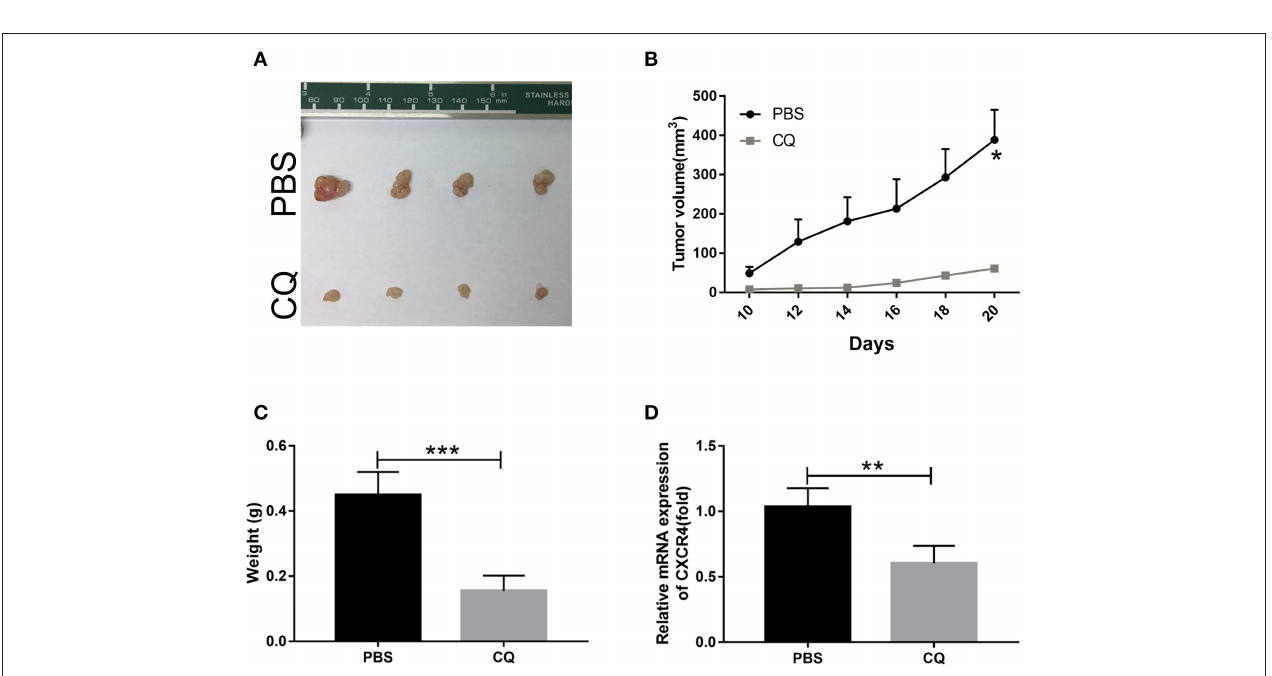
FIGURE 6 | Chloroquine inhibited tumor growth in vivo . (A) Images of the xenograft tumors formed in nude mice. (B) Tumor volume was measured every second day and expressed in mm 3 . (C) Weights of xenograft tumors were summarized. (D) The expression of CXCR4 was confirmed. * P < 0.05, ** P < 0.01, and *** P <